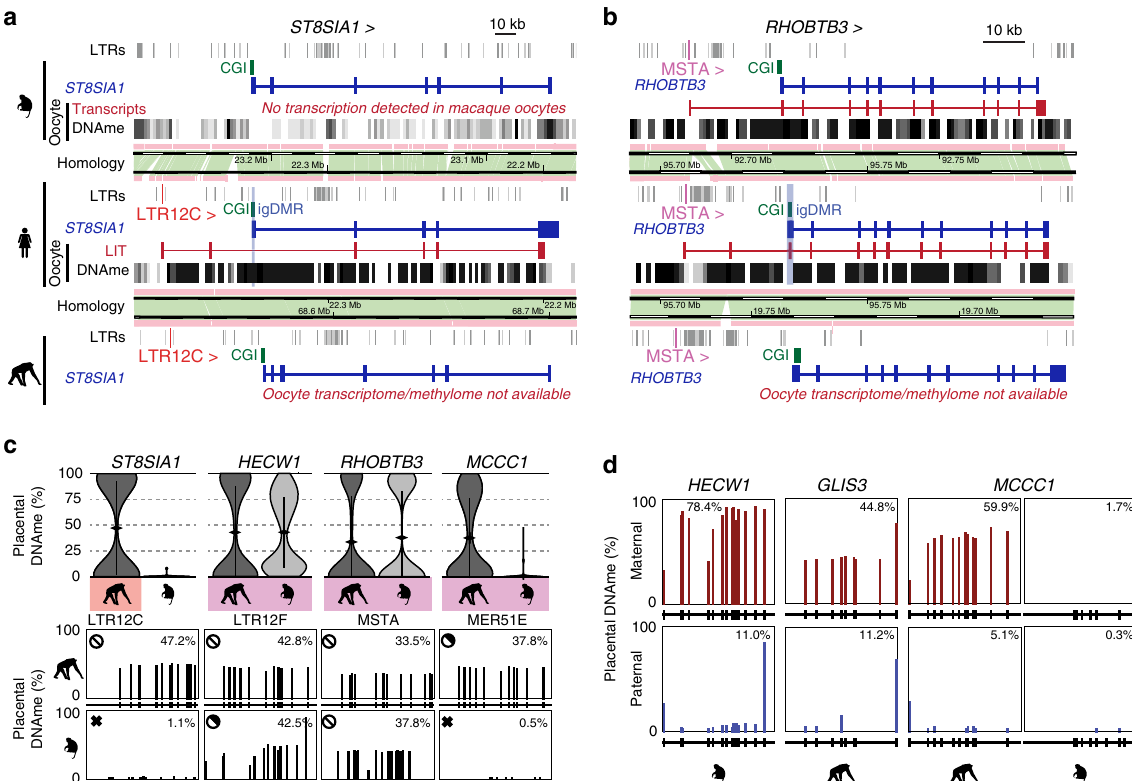
Fig. 3 Chimp and macaque LITs and placental DNAme. a Screenshot of the human ST8SIA1 locus, showing its CGI promoter (green), annotated gene (blue), oocyte LIT (red), and DNAme in human and macaque oocytes (black). Highlighted are the location of the upstream LTR12C in human and chimp (red) and the human igDMR (blue). b Screenshot of the human RHOBTB3 locus annotated as in a and highlighting the upstream MSTA LTR promoter (pink). c Violin plots of the distribution of mean DNAme levels per strand in placenta (chimp MCCC1 : n = 2 all others: n = 3 biologically independent samples) for individual bisulphite-sequencing reads covering the igDMRs of the orthologous chimp and macaque ST8SIA1 , HECW1 , RHOBTB3 , and MCCC1 genes. Coloured boxes indicate the presence of the proximal LTR. For each gene, the mean DNAme level at each of the CpGs surveyed is shown below. Symbols for DNAme are as in Fig. 2a. Note that the MER51E in the macaque MCCC1 locus is transcriptionally inert, likely due to macaque-speci fi c SNPs rendering it transcriptionally inactive (Supplementary Fig. 4d – f). Source data are provided as a Source Data fi le. d Placental DNAme data at the HECW1, GLIS3 , and MCCC1 loci for informative samples heterozygous at SNPs of known parental origin, are shown for the species